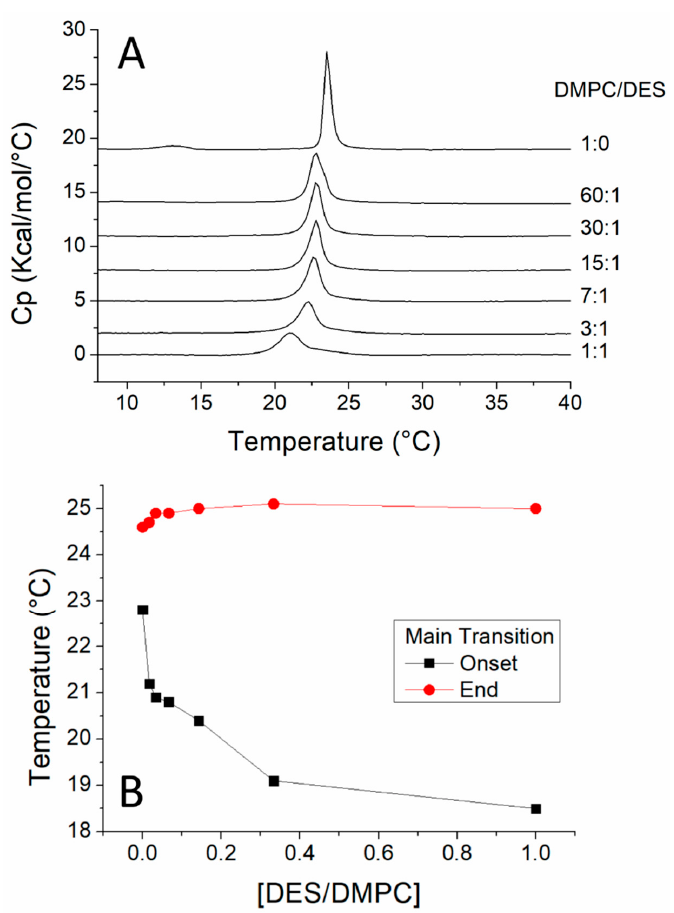
Figure 2. ( A ). Thermograms obtained by using differential scanning for mixtures of DMPC (1,2- dimyristoyl- sn -glycero-3-phosphocholine) and DES. The phospholipid/DES molar ratios are given on the traces. ( B ) Plot of DES/DMPC molar ratios versus temperature, on which the temperatures corresponding to onset and end of phase transitions are plotted. Table 1. Changes in Δ H after the addition of DES to membranes of DMPC and DEPE (1,2- dielaidoyl- sn -glycero-3-phosphoethanolamine). DMPC/DES Molar Ratio Δ H (kcal/mol) 1:0